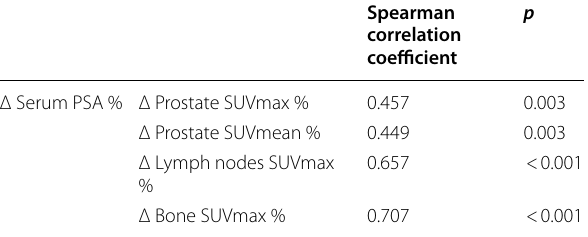
Table 6 The correlations between alteration percantages of serum PSA and SUV